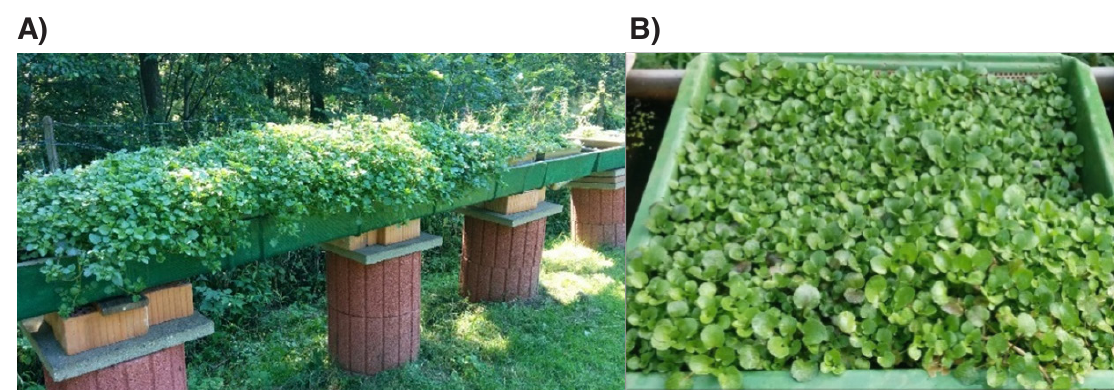
Fig. 1: Cultivation of watercress in A) Poggenhagen in the field and in the B)